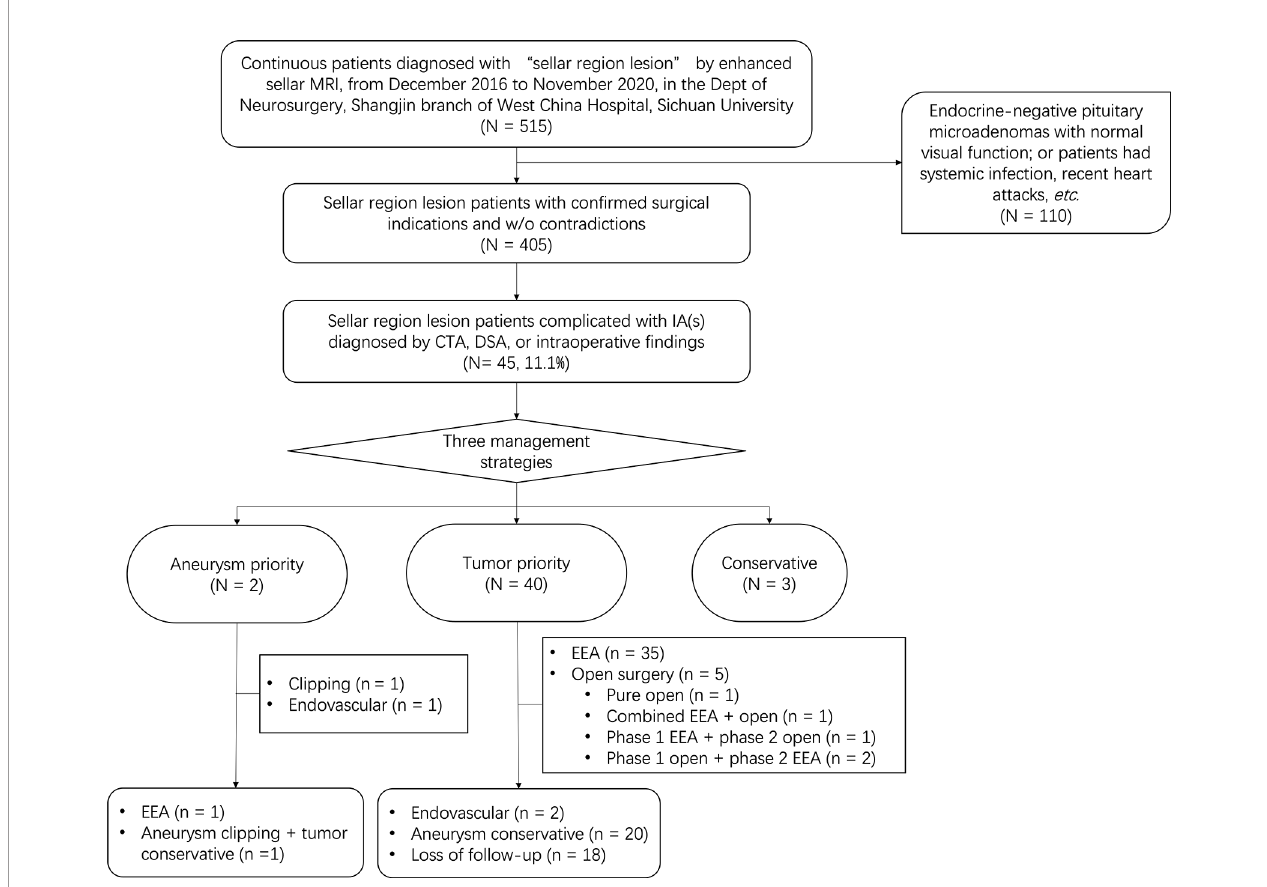
FIGURE 1 | Patient recruitment fl owchart of sellar region lesions complicated with